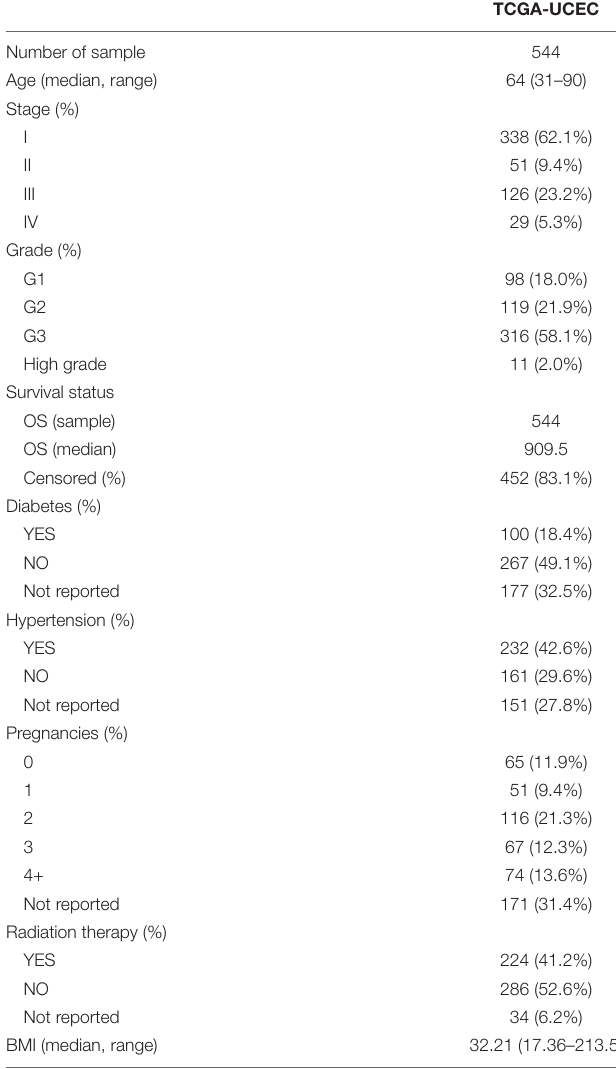
TABLE 1 | TCGA-EC samples’ clinical